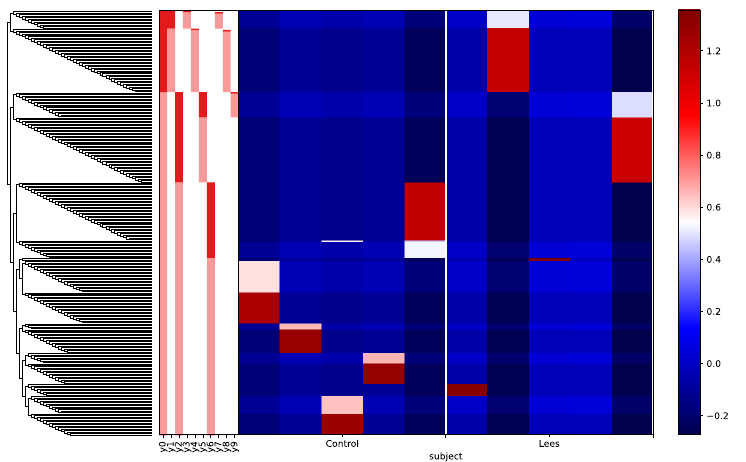
Figure 5. Heatmap of the differential abundance analysis. The numerators for each balance are highlighted in light red, while the denominators are highlighted in dark red.